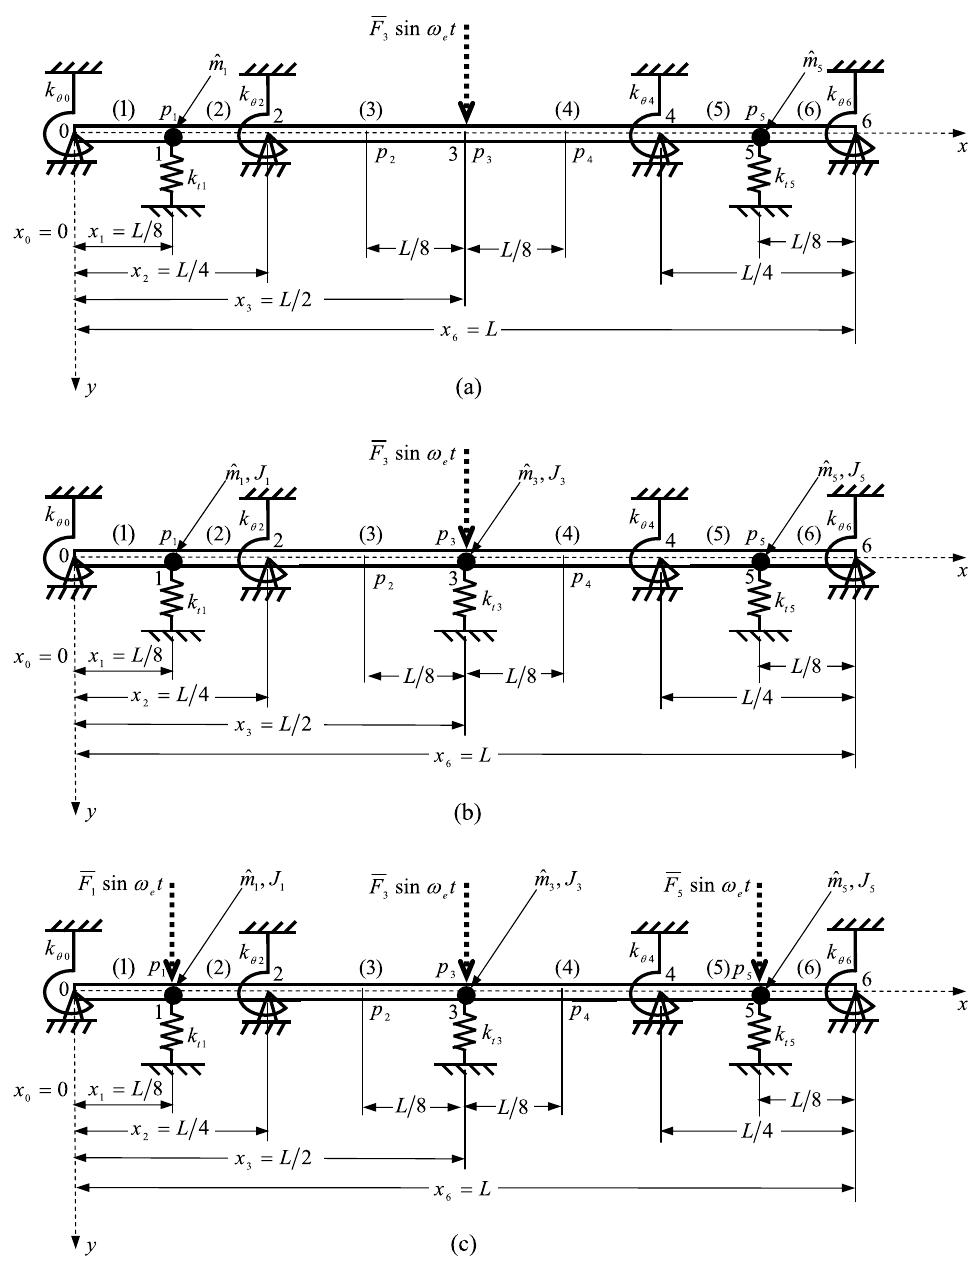
Fig. 6. A uniform beam composed of 6 uniform beam segments ((1), (2), ... , (6)) separated by 5 nodes (1, 2, ... , 5) and spring-hinged at node i with a rotational spring k θ i ( i = 0, 2, 4 and 6): (a) no concentrated elements at the position of single force ¯ F 3 sin ω e t and no rotary inertia J j ( j = 1, 3 and 5); (b) with concentrated elements at the position of single force ¯ F 3 sin ω e t and with rotary inertia J j ( j = 1, 3 and 5); (c) the same as (b) but having 3 forces ¯ F j sin ω e t at node j ( j = 1, 3 and